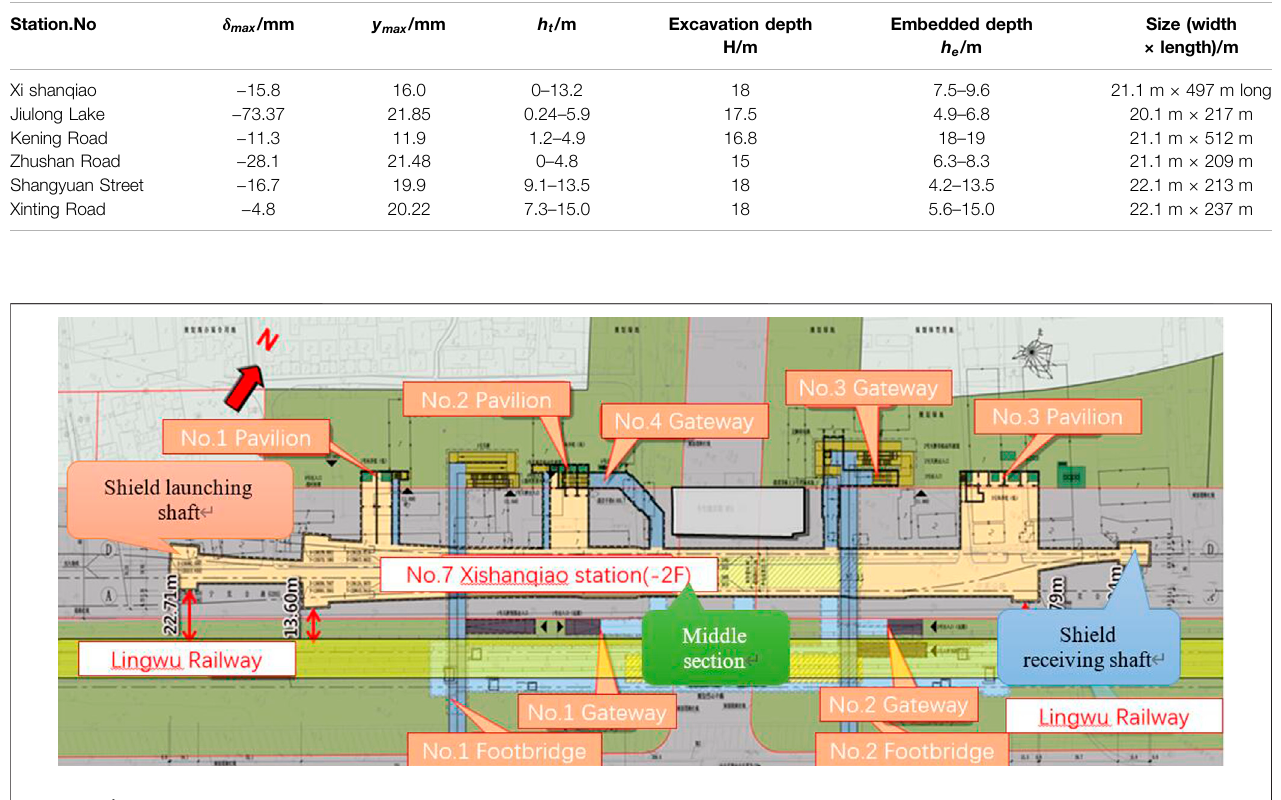
Frontiers in Physics |